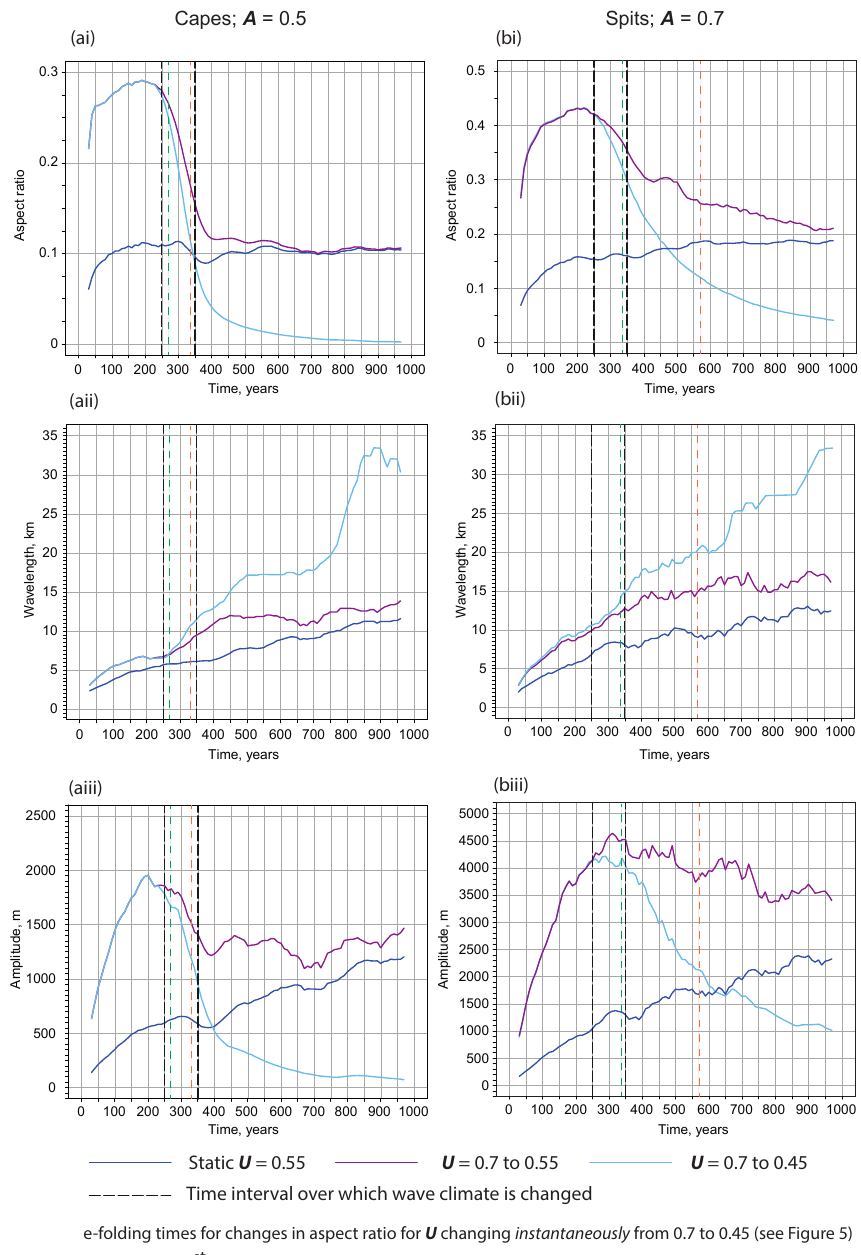
Figure 4. Time series of the evolution of aspect ratio (amplitude / wavelength), wavelength and amplitude for (ai–iii) capes and (bi–iii) spits under 100 years of gradual change in wave climate, from 250 years. In all panels, the dark blue line: results for the coastline evolved under a static wave climate with U = 0 . 55 for both spits and capes; light blue line: progressive change in U from 0.7 to 0.45 over 100 years; and purple line: progressive change in U from 0.7 to 0.55 over 100 years. The e -folding times are shown graphically for 900-year models (see Fig. 5). These relate specifically to change from U = 0 . 7 to U = 0 . 45 based on change in aspect ratio and are shown to provide additional context for timescales of gradual change. See text and Supplement. Note: data are smoothed by a seven-point moving average to aid clarity. The indication of change in morphology slightly before 250 years is an artefact of this